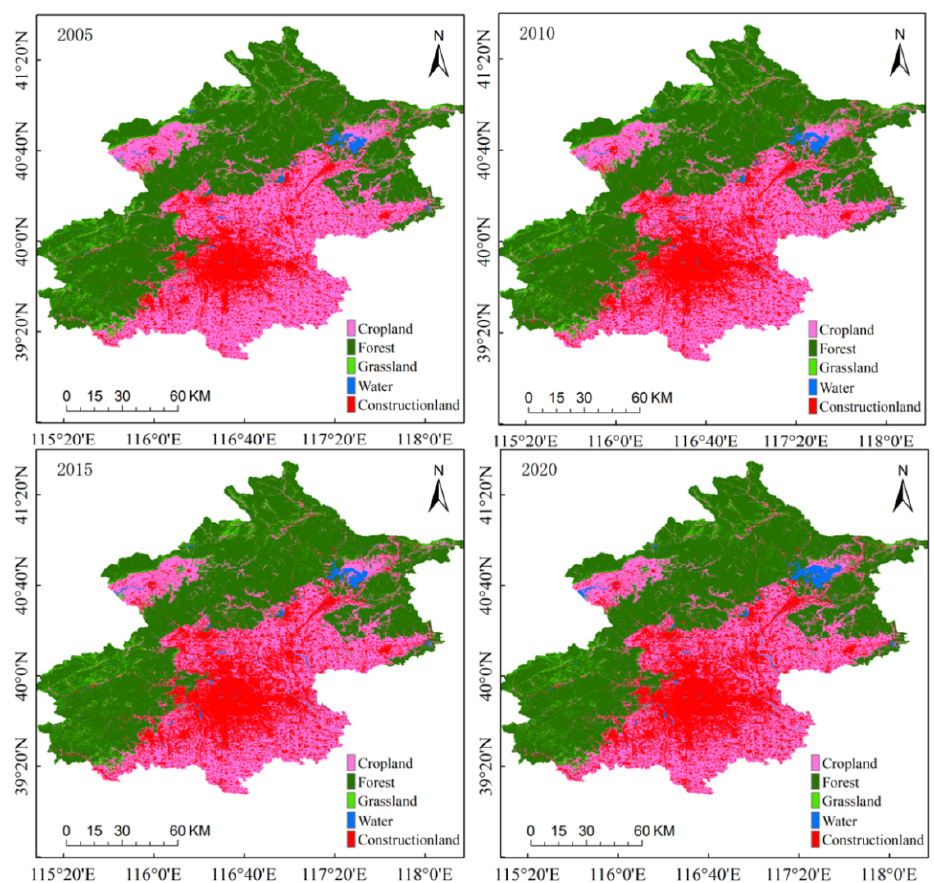
Figure 10. Land use types in Beijing from 2005 to 2020. Table 2. Statistical results of different land types in Beijing (2005–2020). Land Use and